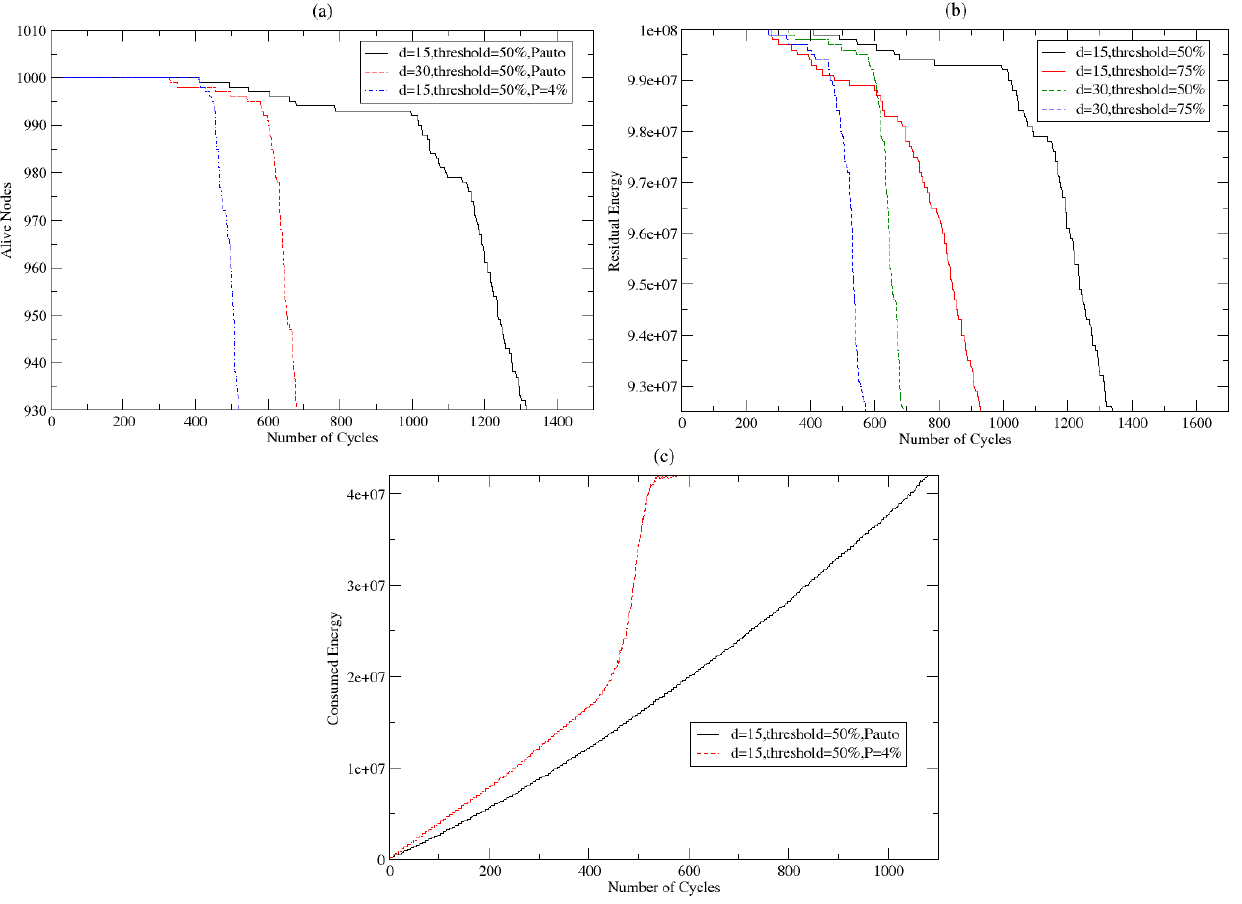
Figure 19 . (a) Alive Nodes in the WSN, (b) Residual Energy in the WSN and (c) Consumed Energy in the